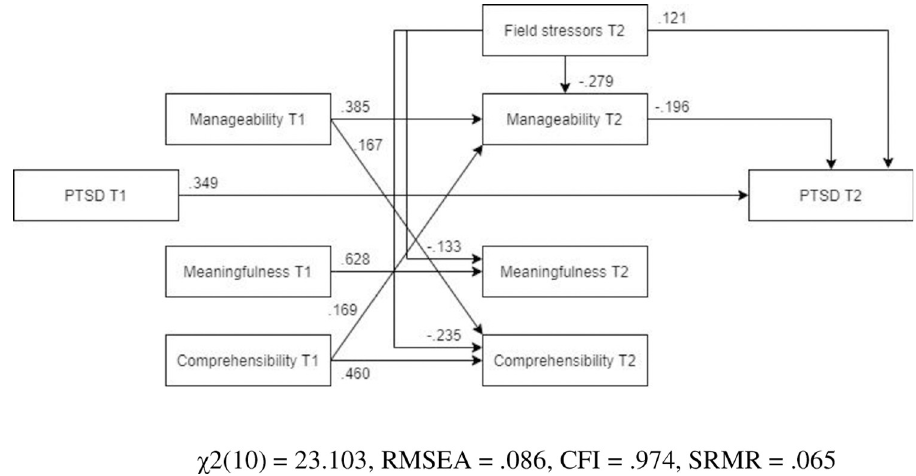
Fig 16. Tested structural equation model for PTSD—males. χ 2(10) = 23.103, RMSEA = .086, CFI = .974, SRMR = .065.